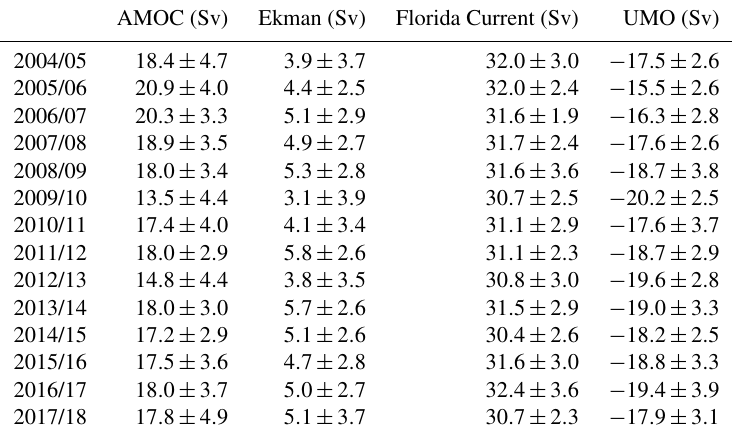
Table 1. The annual means of the AMOC volume transport and components in Sverdrups (1Sv = 10 6 m 3 s − 1 ). Values are given as the annual mean ± the standard deviation of the 10-day binned values for that year. Annual means are computed from 1 April to 31 March. Positive values indicate northward transport, while negative values are southward. The decorrelation time is of the order of 20–30 days for all variables, and so the standard error is about square root (1 / 12) multiplied by the standard deviation. The decorrelation time is 20–35 days √ √ ( 1 / 18 ) and ( 1 / 10 ) multiplied by the standard deviation. for all variables, and so the standard error is between